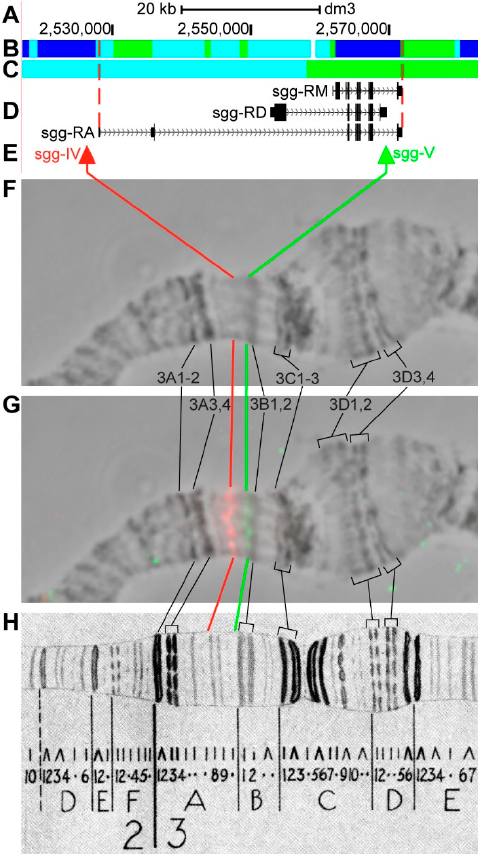
Figure 11. Localization of the sgg gene in the 3AB region (the gene is bound by red dotted lines). ( A ) the scale (kb) and genomic coordinates (bp); ( B ) the four chromatin-state model [39]; ( C ) the chromatin condensation level model [32]; ( D ) genes location (arrow lines show the gene orientation and black bars indicate the location of gene exons); ( E ) probes location; ( F ) phase-contrast micrograph of the region; ( G ) combined FISH signals; and, ( H ) C. Bridges’ chromosome map